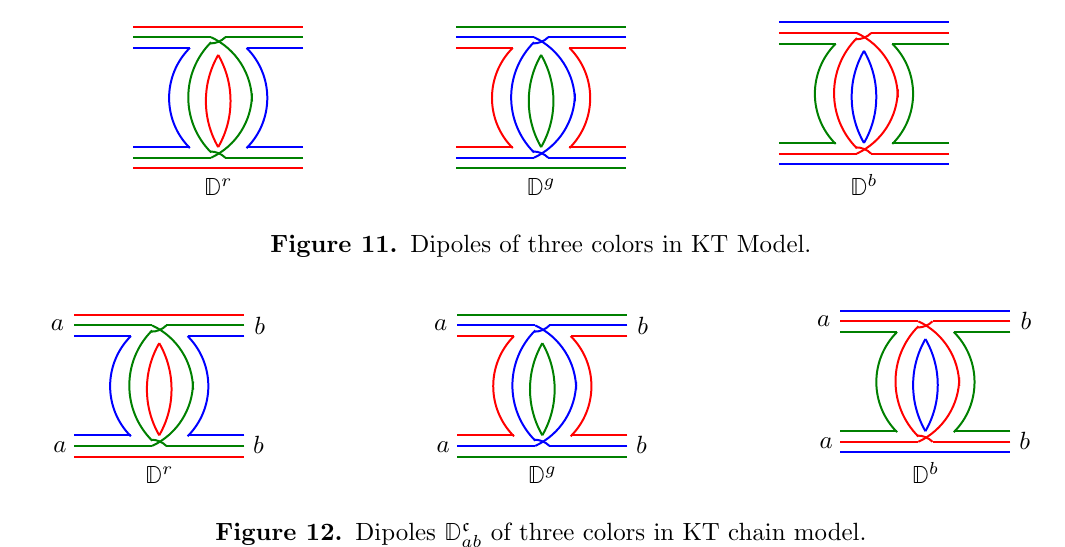
of three colors in KT chain ab